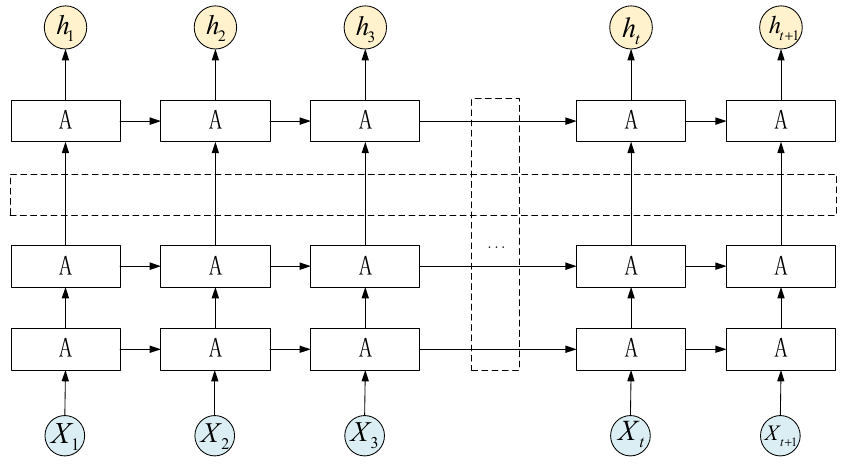
Figure 2. Multilayered neural networks of LSTM.